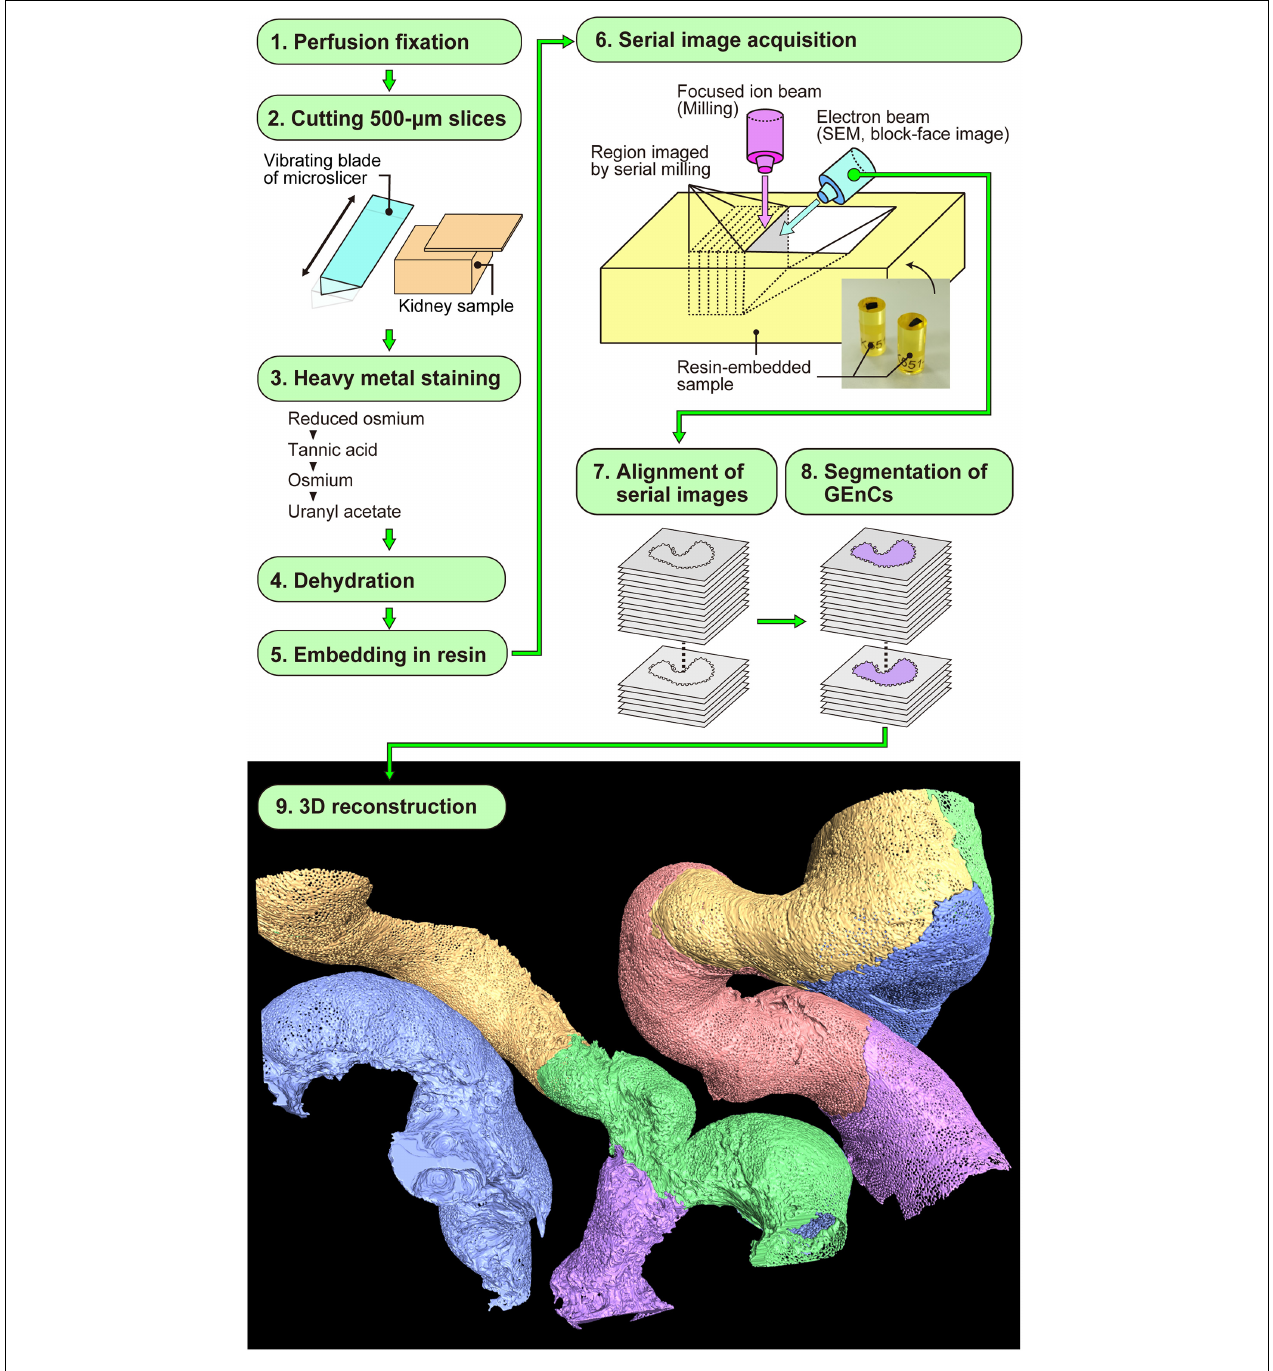
FIGURE 2 | Focused-ion beam-scanning electron microscopy (FIB-SEM) tomography and 3D reconstruction of glomerular endothelial cells (GEnCs). The series of this method is largely divided into nine steps (1–9). Finally, the color-coded 3D reconstruction images of GEnCs are produced.